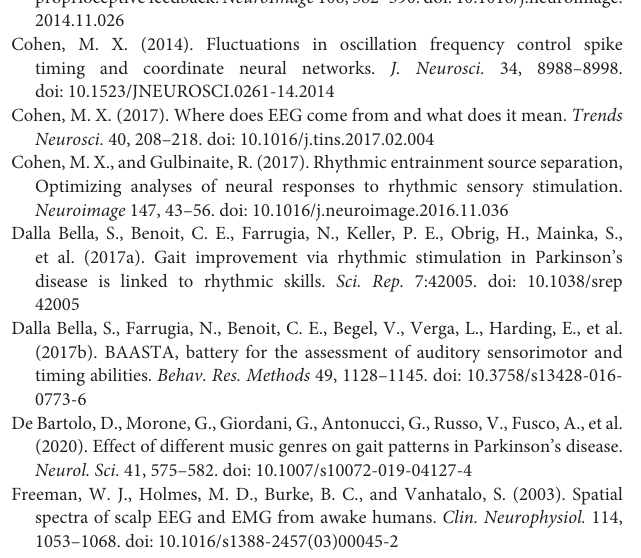
SUPPLEMENTARY FIGURE 2 | Component #2. As it can be evicted by the right-most plot, the second eigenvalue detaches to some extent in the eigenspectrum. We present here the activation map and the power spectrum (normalized to signal-to-noise ratio) of the component associated with the second eigenvalue. The spectral profile is clearly characterized by dominant peaks at entrained frequency and harmonics, which is to be expected given the spectral criterion adopted for the GED. It is noteworthy that the signal-to-noise ratio is considerably lower as compared to the first component. Critically, no meaningful pattern emerged from the topographical activation map.